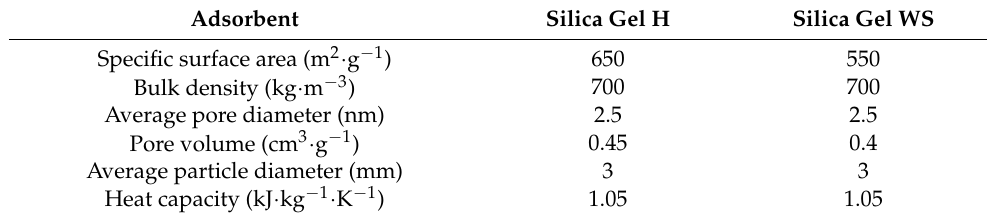
Table 1. Characteristics of adsorbents.